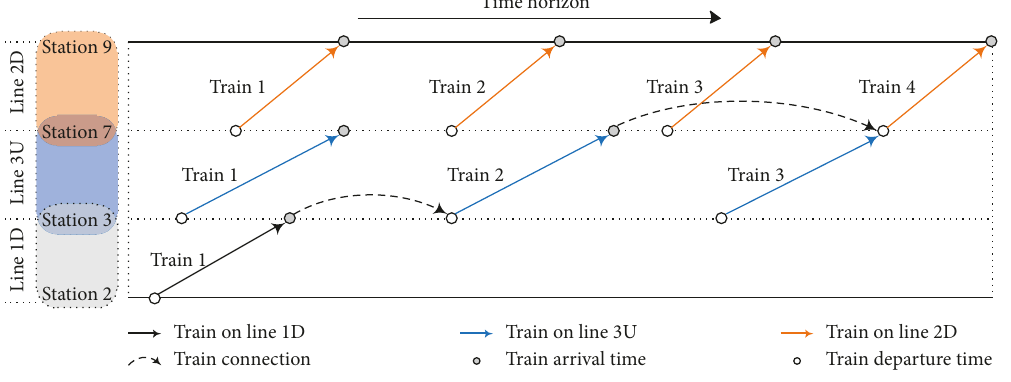
Figure 3: Train-connection-based route.